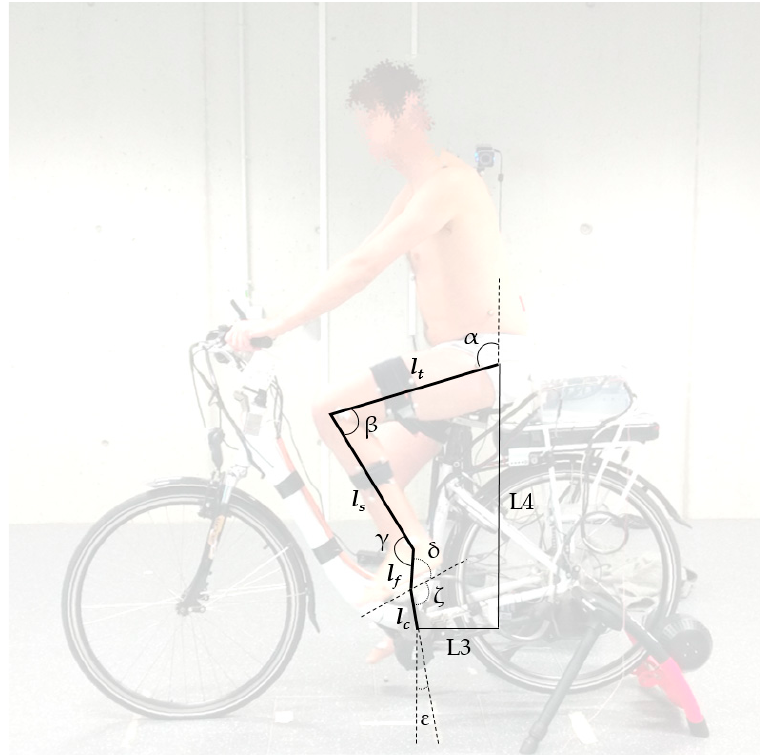
Figure 4. Schematic overview of the angles and segment lengths.